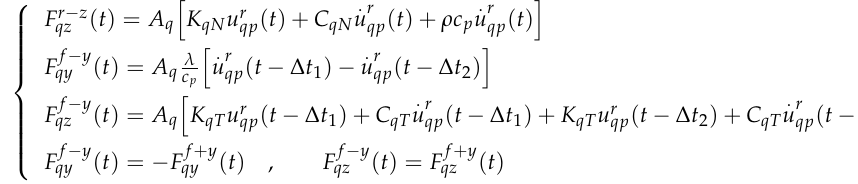
where K and C are the artificial boundary parameters of q ; q q